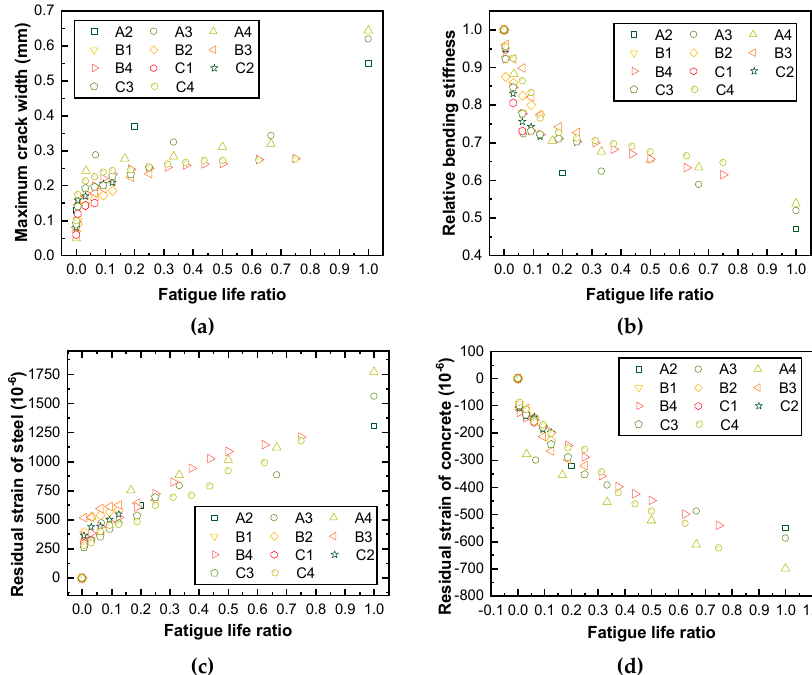
Figure 6. The fatigue behavior of reinforced concrete (RC) beams with different loading cycles: ( a ) maximum crack width; ( b ) bending stiffness; ( c ) residual strain of concrete in compressed zone; ( d ) residual strain of tensile reinforced bars.